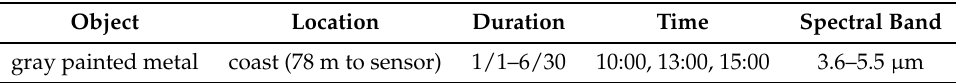
Table 1. Database acquisition environment of the midwave hyperspectral spectrum.